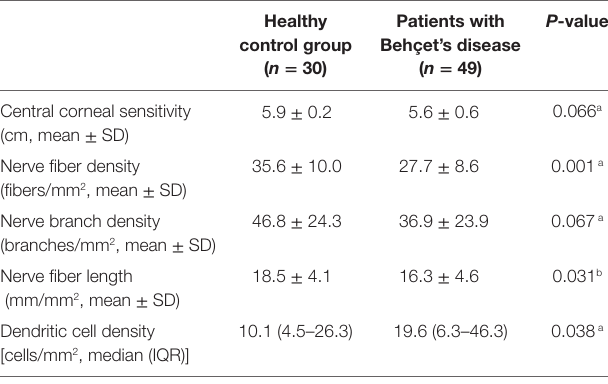
healthy Patients with P -value control group Behçet’s disease ( n = 30) ( n = 49)